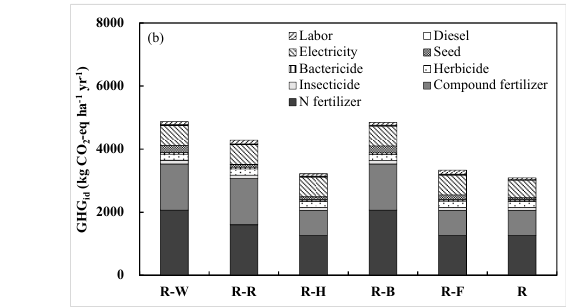
Figure 2. Effects of different cropping systems on the direct and indirect GHG emissions: ( a ) direct GHG emissions of N 2 O and CH 4 in 2020 – 2021; ( b ) indirect GHG emissions from agricultural inputs of the annual mean values during the experimental period. Vertical bars represent the standard error ( n = 3) and different lowercase letters indicate significant differences among treatments ( p < 0.05). R – W, rice – wheat; R – R, rice – rape; R – H, rice – hairy vetch; R – B, rice – barley; R – F, rice – faba bean; R, rice – fallow. Table 4. Effects of rice-based cropping systems on the carbon footprint. Treatments